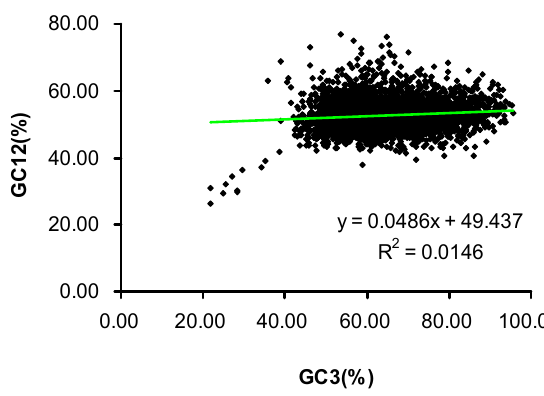
Figure 1. Neutrality plots (GC12 vs. GC3).GC12 stands for the average value of GC content in the first and second position of the codons (GC1 and GC2). While GC3 refers to the GC content in the third position. The solid line is the linear regression of GC12 against GC3, R 2 = 0.0146, p < 0.01.